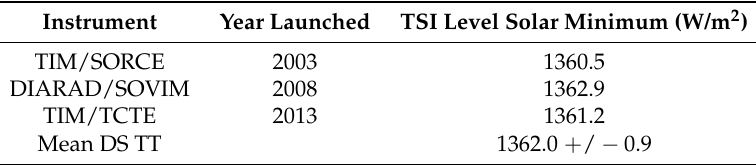
Table 2. Alternative TSI levels at solar minimum. TCTE: Total Solar Irradiance Transfer Experiment.